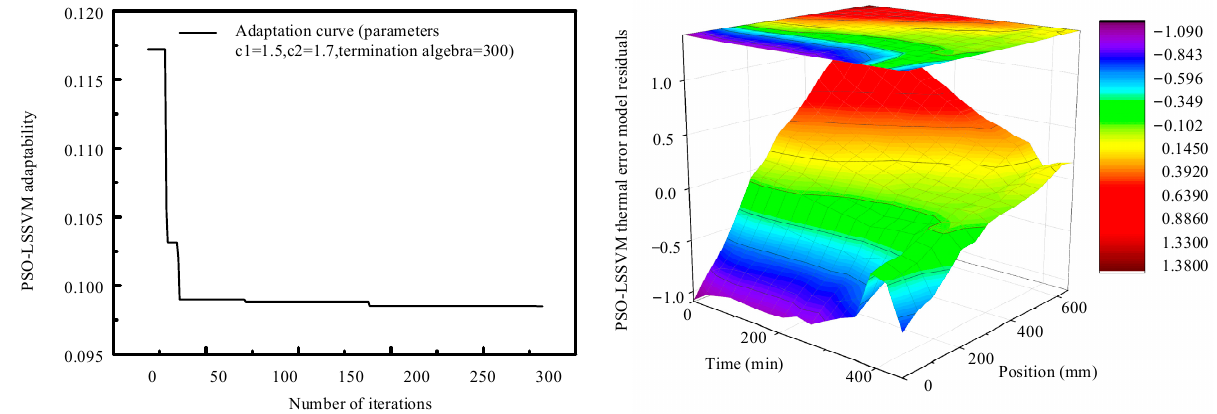
thermal error model under separate motion parameters has excellent predictive capabil- Figure 15. PSO-LSSVM adaptation iteration curves with LSSVM residual plots.